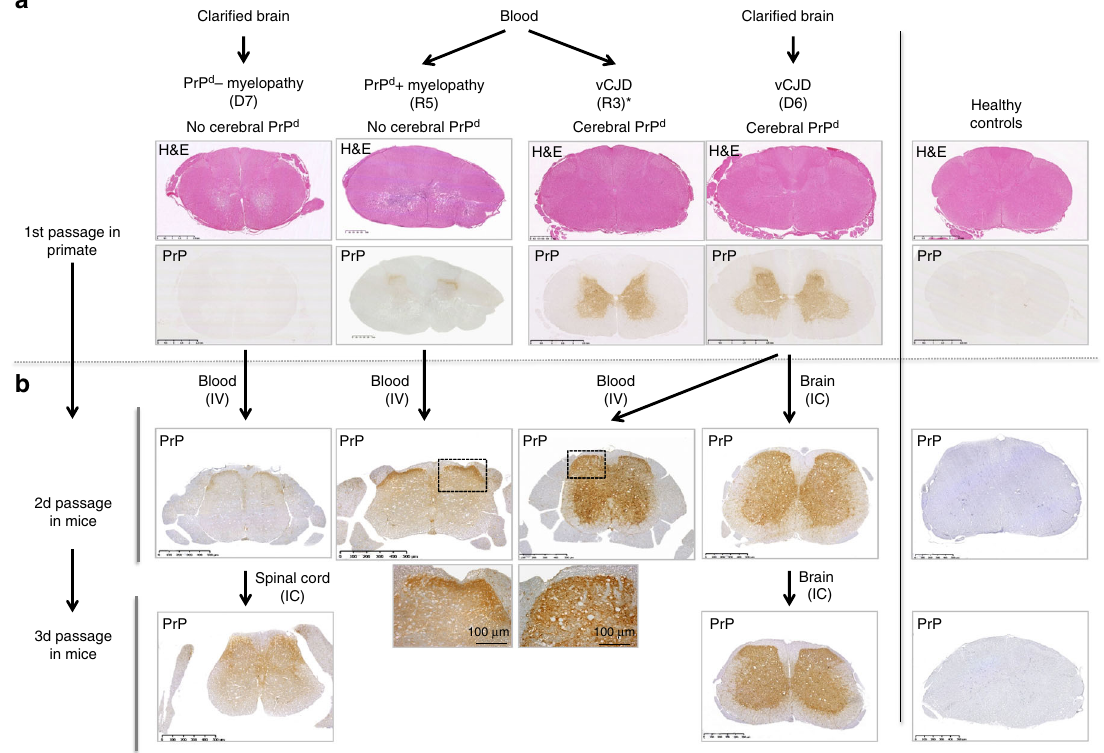
Fig. 6 Serial transmissions of myelopathy and vCJD from macaques to mice. a Primates exposed to blood or cerebral products derived from vCJD-infected macaques developed vCJD (primates R3 and D6) or myelopathy (primates R5 and D7, Supplementary Text 1). Interestingly primate R3 (duplicate of primate R5) developed vCJD with spongiform changes and accumulation of PrP d in its brain and spinal cord, but it also exhibited myelopathic lesions (pseudo-necrotic lesions in the brainstem and demyelination of posterior tracts) and limited amounts of PrP d in its brain (around 10-fold lower than the other vCJD primates). b Corresponding blood and brain samples were inoculated intravenously (IV) or intracerebrally (IC) into Swiss mice. The lesions observed in spinal cords of macaques are presented (hemalun – eosine, H&E). The presence of PrP d in the spinal cords was detected